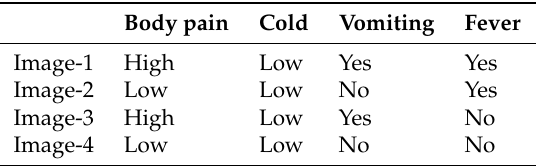
Table 3. A Sample Decision